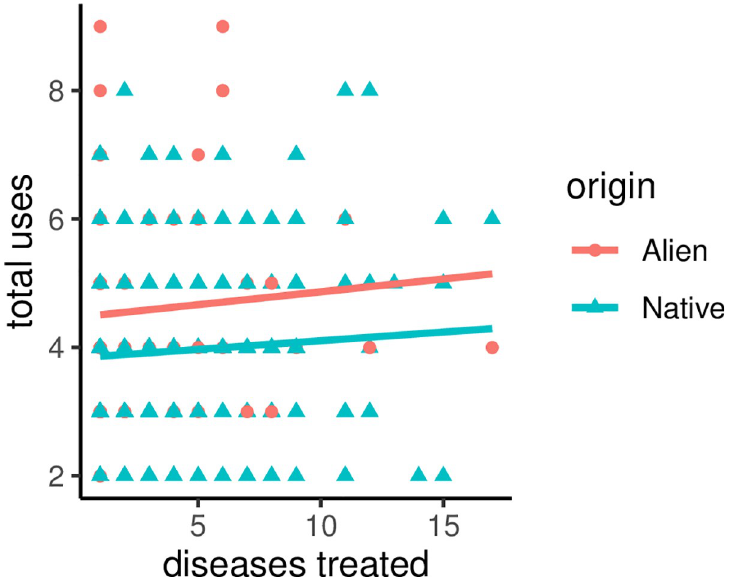
Fig 4. Versatility patterns of alien vs. native